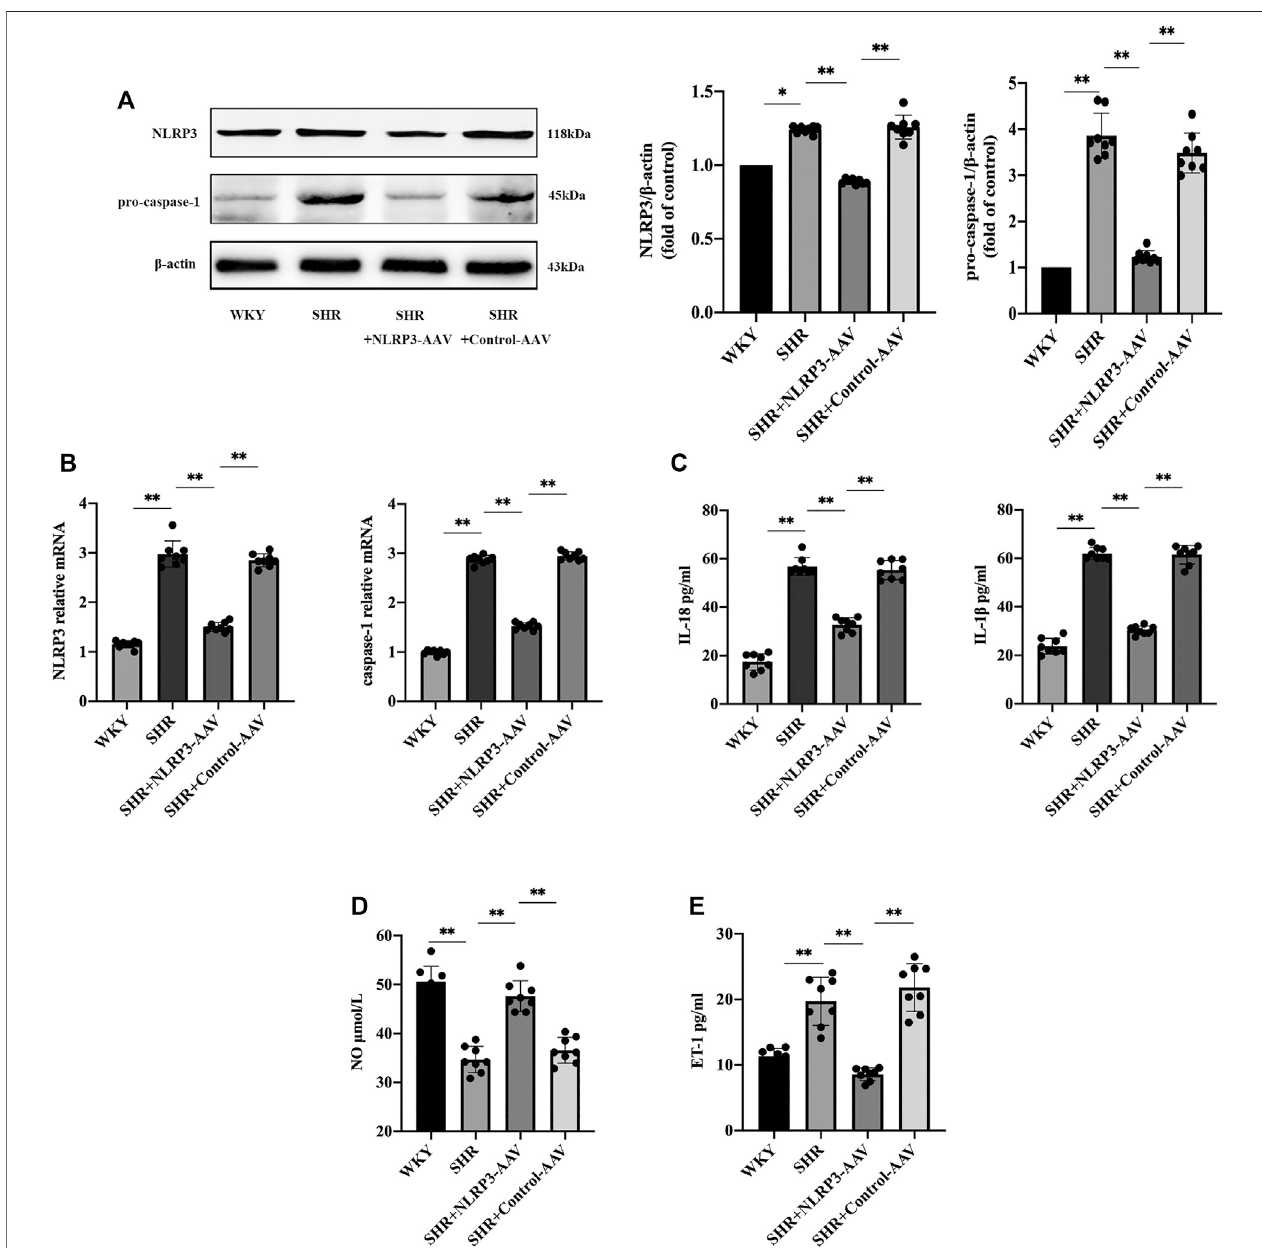
FIGURE 1 | The activation of NLRP3 in fl ammasome played a crucial role in endothelial dysfunction in SHRs ( n (cid:2) 8). (A) Western blot analysis of the expression of NLRP3 and pro-caspase-1 in WKY, SHR, SHR + NLRP3-AAV and SHR + Control-AAV groups. The data were presented in fold of control. (B) PCR analysis of the expressionofNLRP3andcaspase-1inabovefourgroups. (C) ELISAanalysisofthelevelsofIL-1 β andIL-18inabovefourgroups. (D) ELISAanalysisofthelevelofNOin above four groups. (E) ELISA analysis of the level of ET-1 in above four groups. All data were shown as mean ± standard deviation (SD) (error bars) from eight independent biological repeats experiments, each of which included three technical repeats. * p < 0.05; ** p < 0.01.